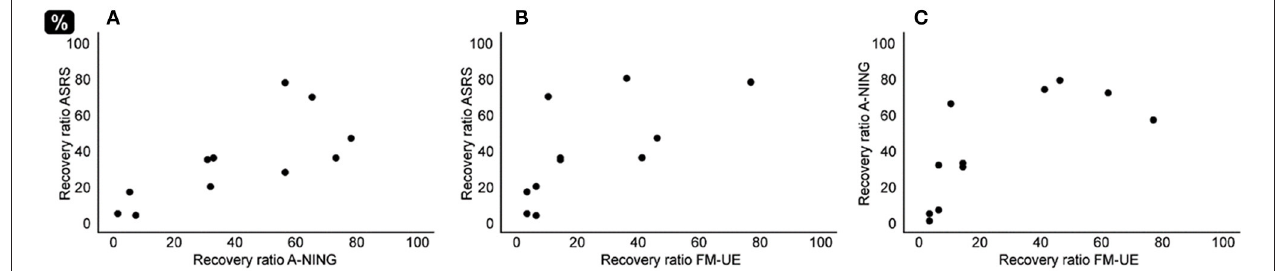
FIGURE 2 | Relation recovery ratios. (A) AOS recovery ratio (ASRS) correlated with recovery ratio of aphasia (A-NING) (Rho = 0.80, p < 0.01). (B) AOS recovery ratio (ASRS) correlated with recovery ratio of hand motor impairment (FM-UE) (Rho = 0.78, p < 0.01). (C) Aphasia recovery (A-NING) correlated with recovery of hand